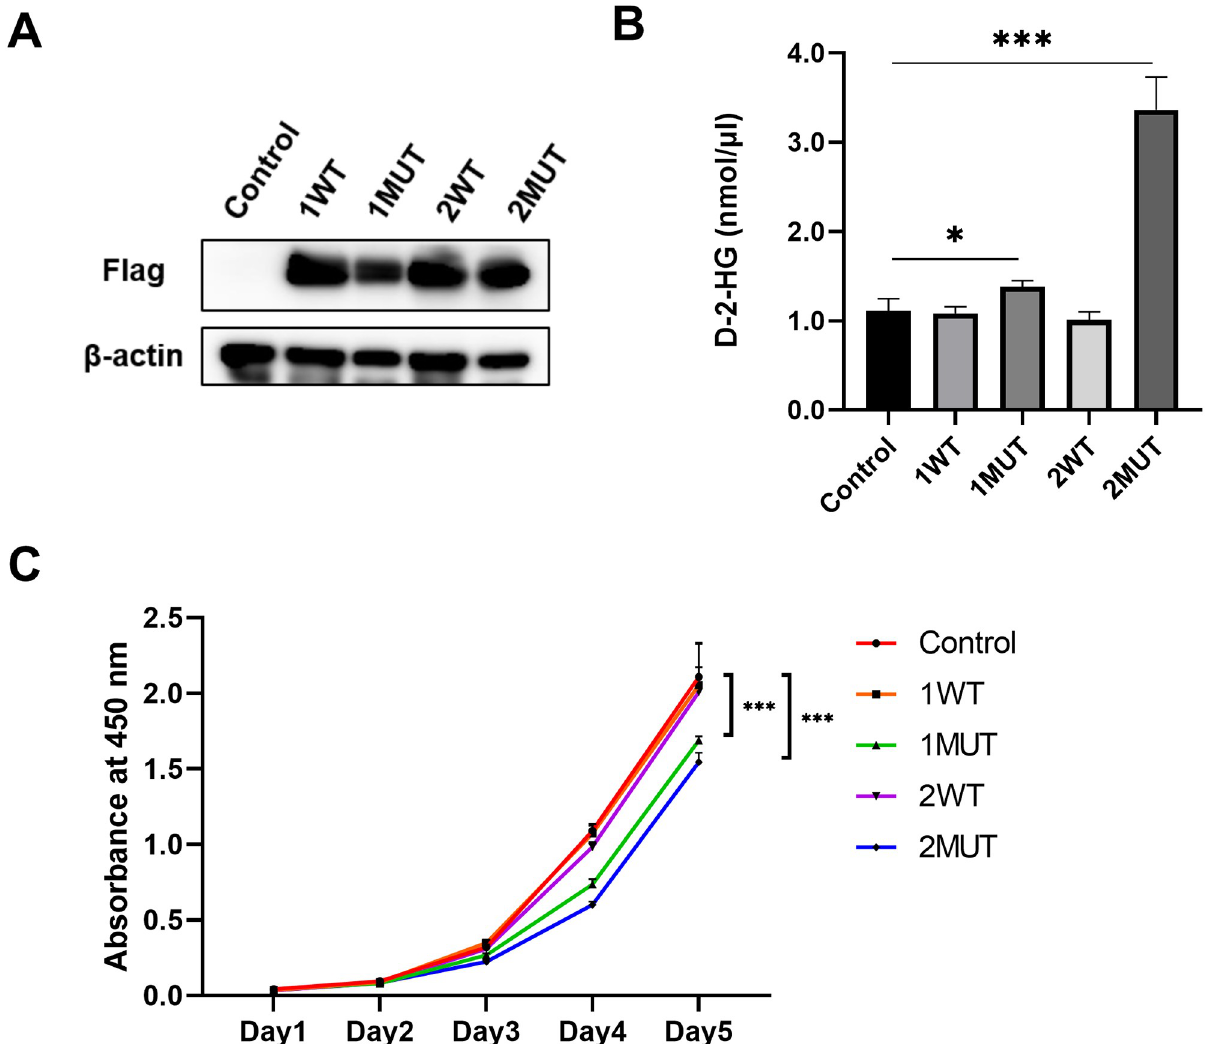
Fig 1. Effect of wild type and mutant IDH1/2 on 2-HG and cellular proliferation. (A) Western blot analysis of the MEF-1WT, MEF-1MUT, MEF- 2WT, MEF-2MUT and control MEF cells. Expression of β -actin served as an internal control. (B) Concentration of 2-HG in the lysates from cells indicated in (A). The data represent mean ± SD of three independent experiments. � p < 0.05, ��� p < 0.001. (C) The proliferation of cells was measured by WST-8 assay. The data represent mean ± SD of three independent experiments. ��� p < 0.001.